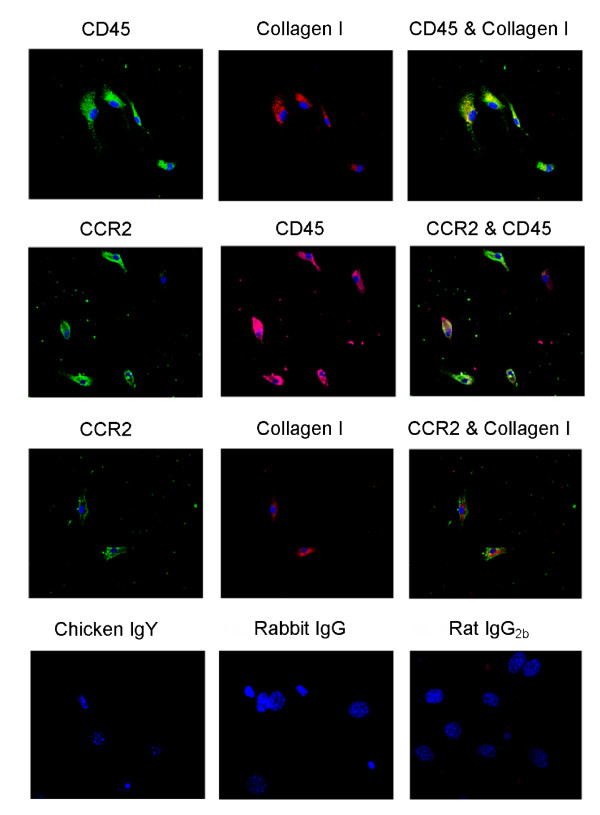
Positive chemokine (C-C motif) receptor 2 (CCR2) expression in murine blood fibrocytes by confocal microscopy. Fibrocyte cultures were costained with CD45 and collagen I (A), CCR2 and CD45 (B), or CCR2 and collagen I (C). Fibrocytes were stained with isotype controls chicken IgY, rabbit IgG, and rat IgG2b(D). Nuclei were stained with 4',6-diamidino-2-phenylindole (DAPI; blue). Cells were examined at 40 × magnification. Representative images from blood pooled from n = 30 mice.